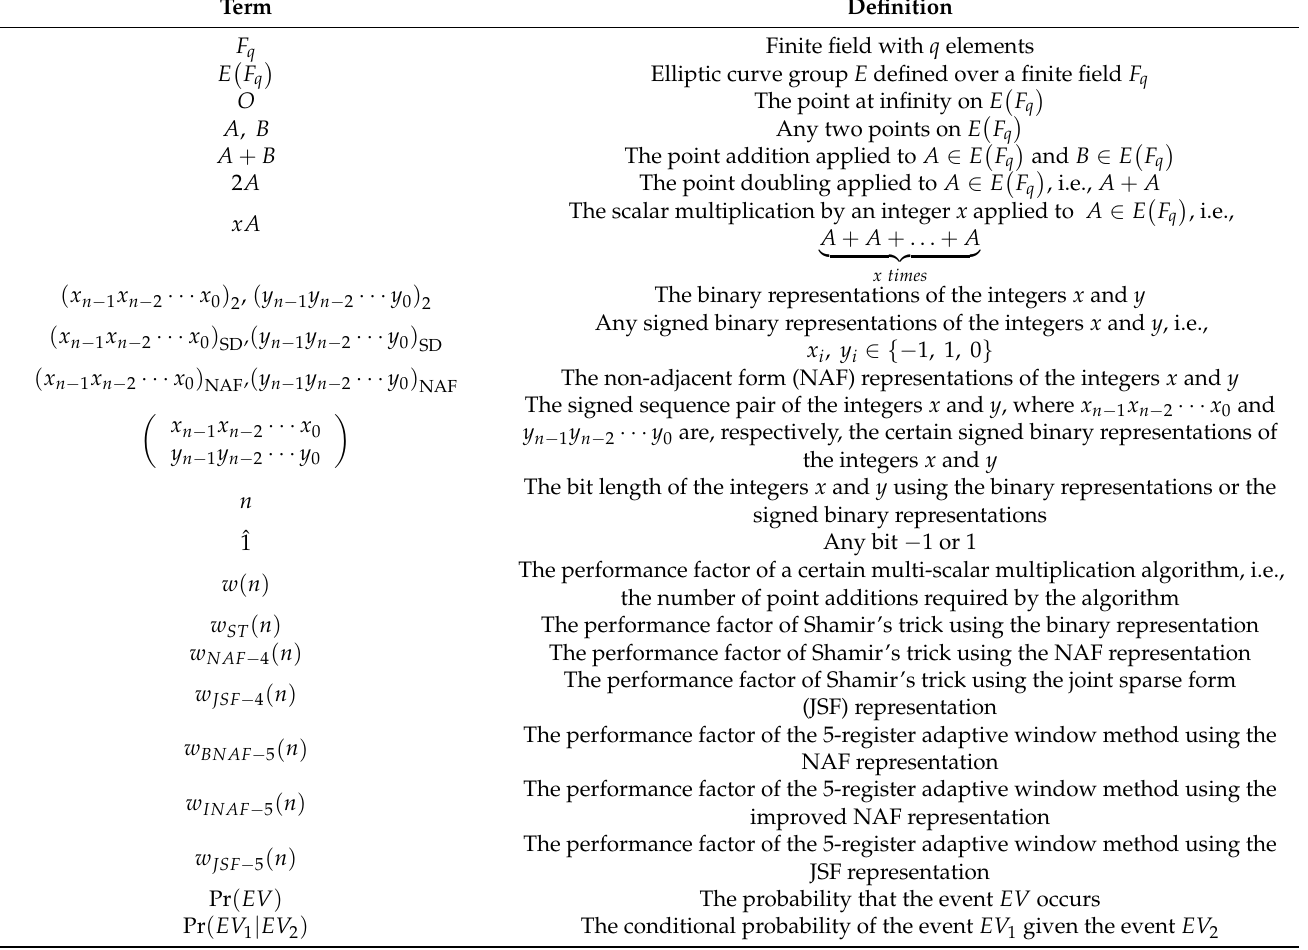
Table 1. Description of